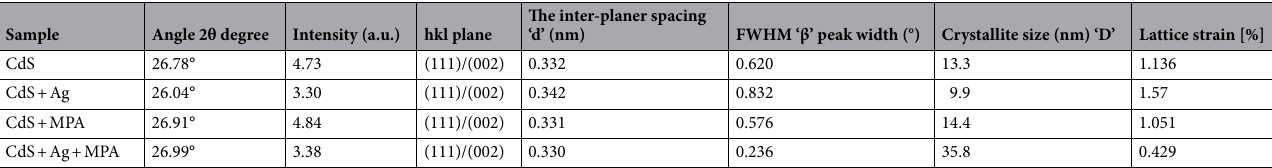
Table 2. Structural parameters of CdS thin